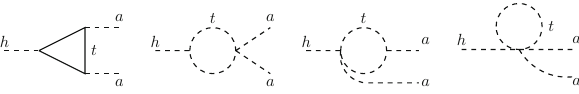
Fig. 5 Top loop diagrams contributing to the effective coupling h → aa